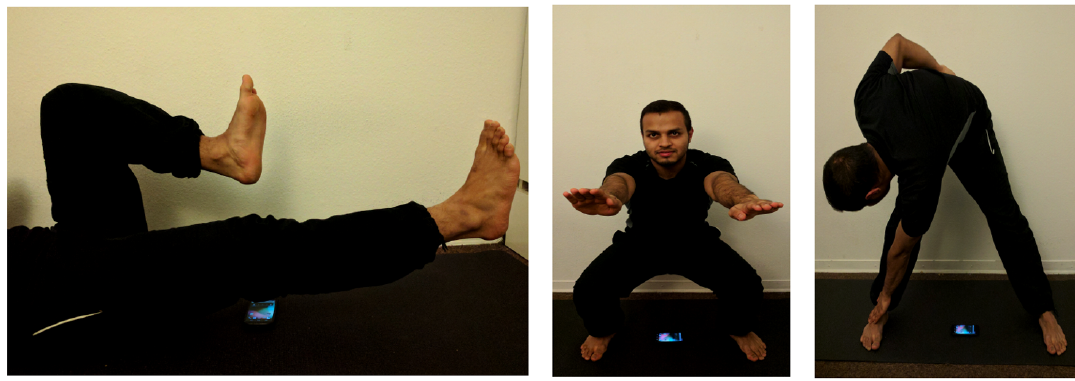
Figure 1. The three different sports activities monitored: bicycle exercise ( left ), squat exercise ( middle ) and toe touch exercise ( right ). The placement of the smartphone is close to the wall due to a stronger